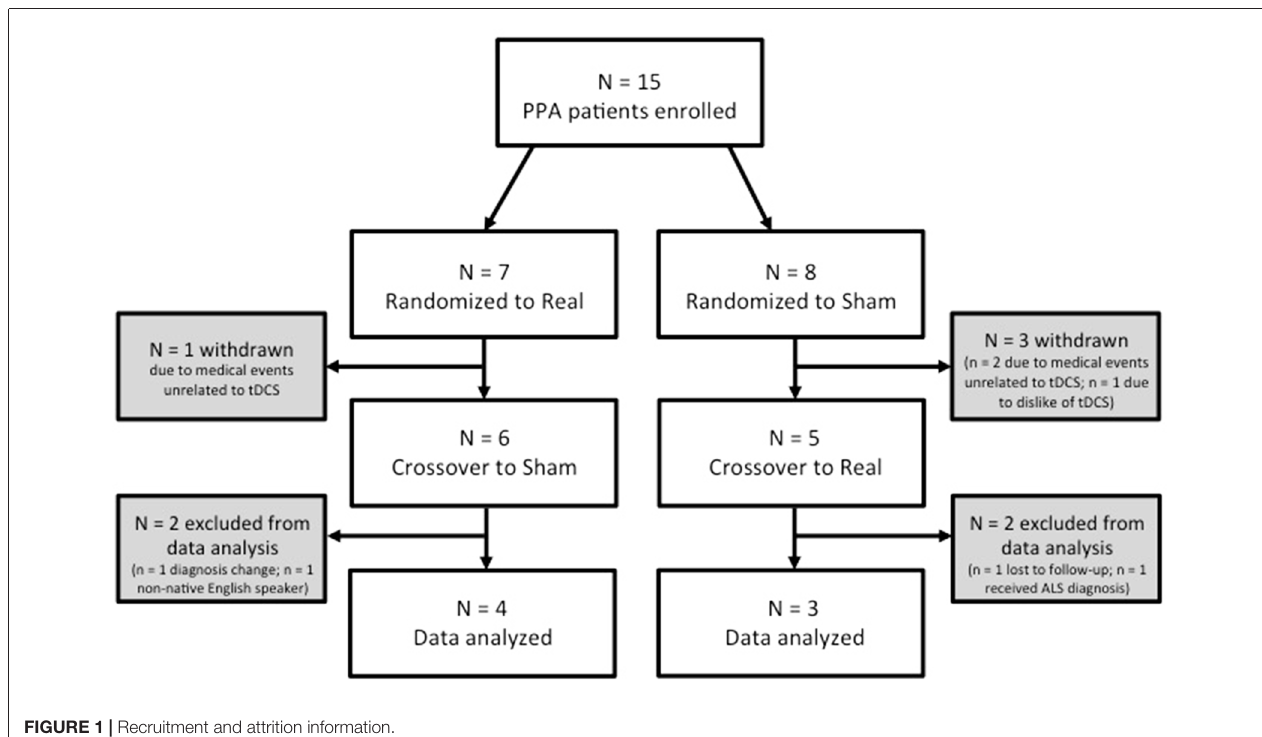
FIGURE 1 | Recruitment and attrition information.